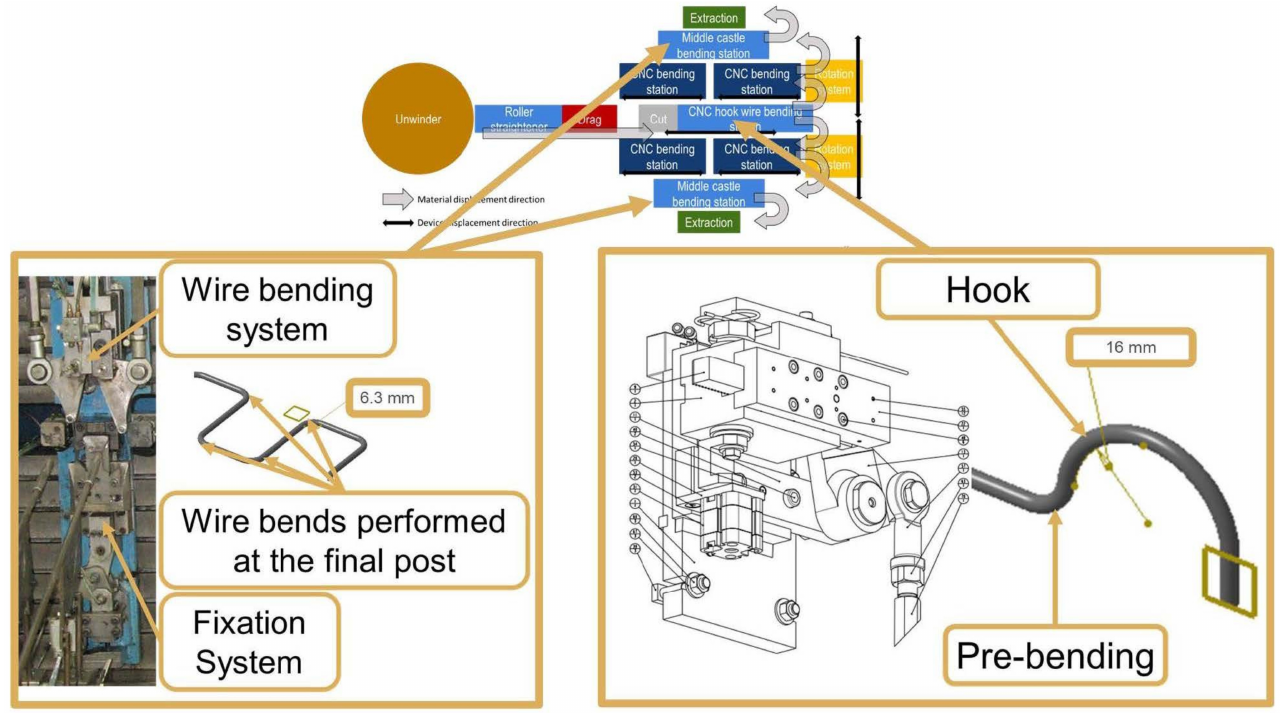
Figure 18. Wire-bending station added to the